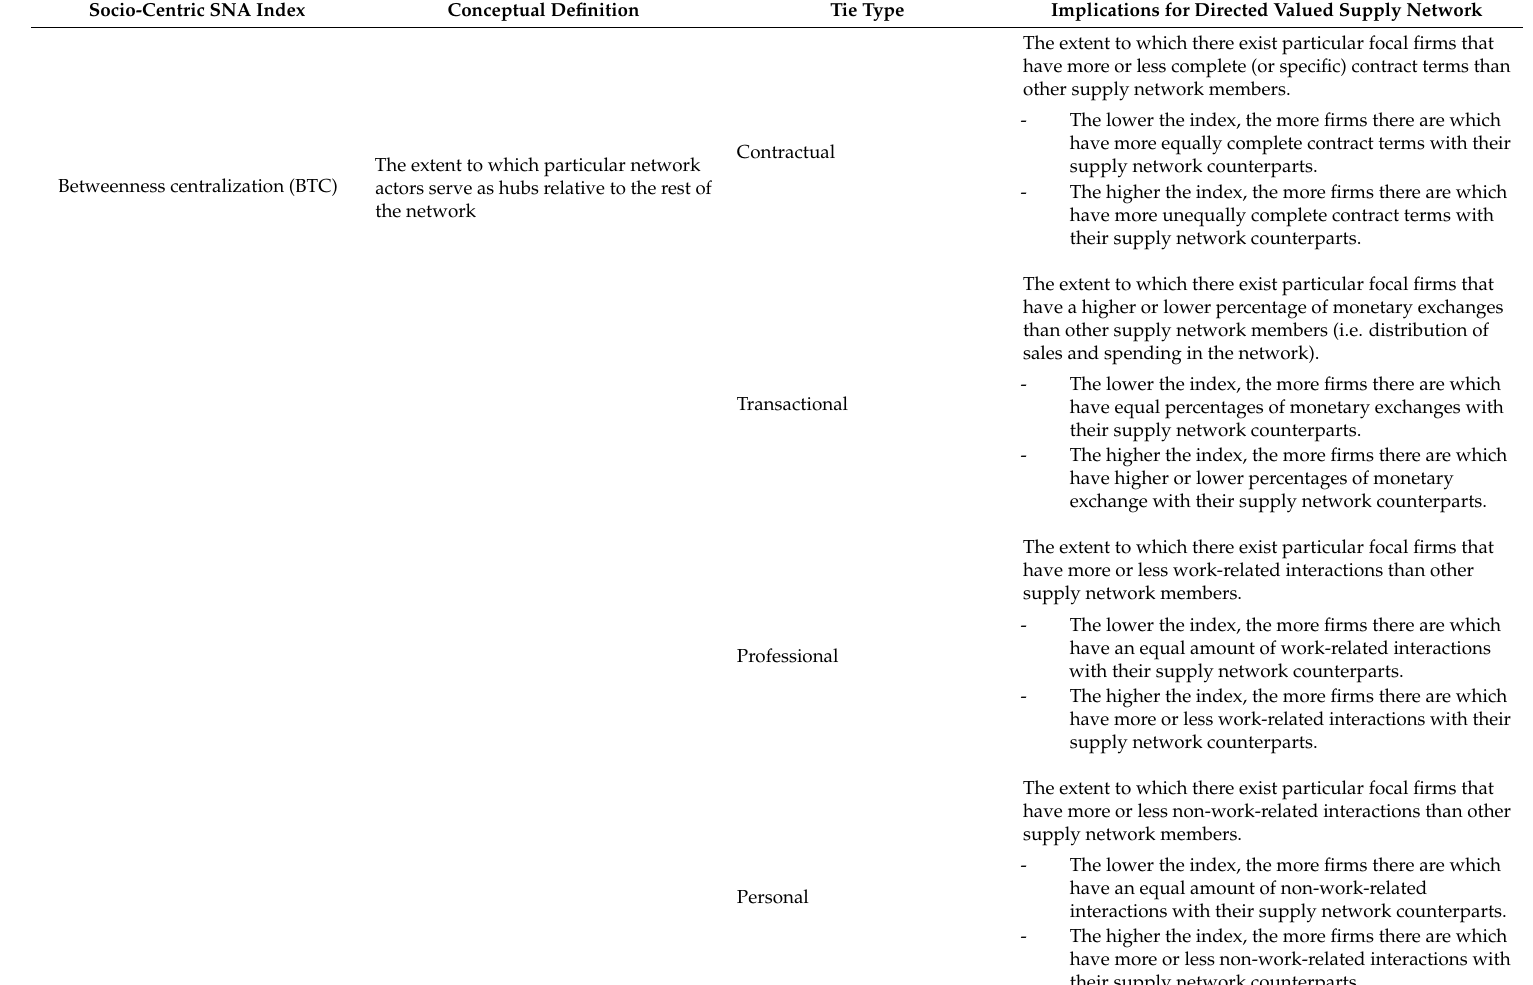
Table 2. Socio-centric indices, conceptual definitions, and interpretations by supply network